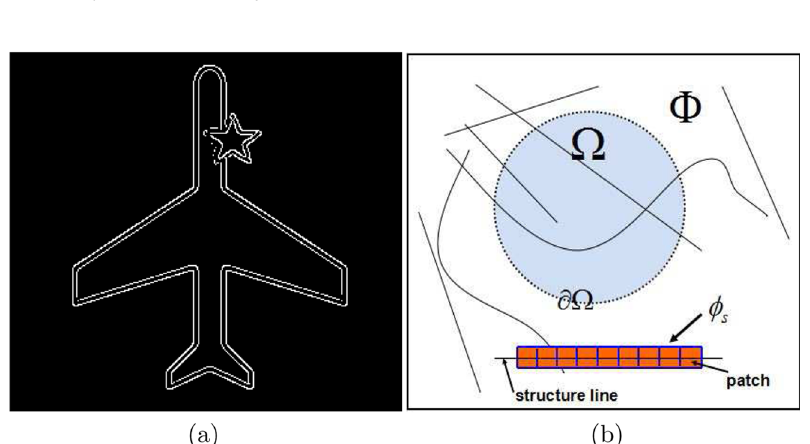
Fig 4. (a) The edge image of “ plane ” by “ canny ” edge detector; (b) a structure bar ϕ s (orange part), blue frames are the filling patches which have a central black structure line (note that we regard edges as structure is computed by the sum of all structure bars in Φ (color images are better lines in our work). In particular, A Φ s visualized in the pdf file).